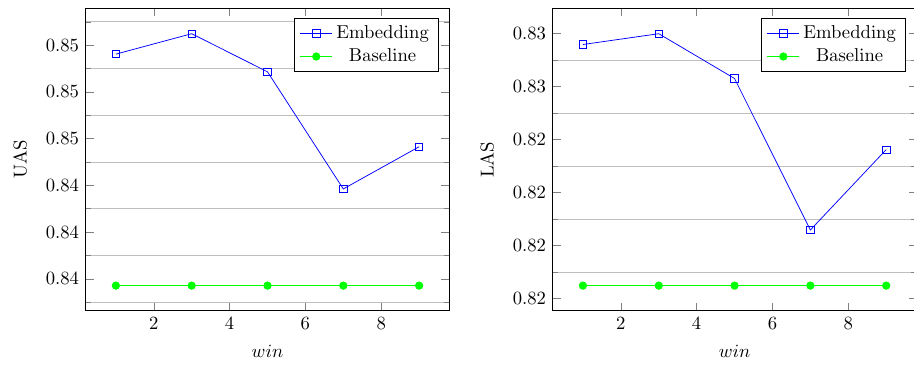
Figure 2. The parsing accuracy under different win .